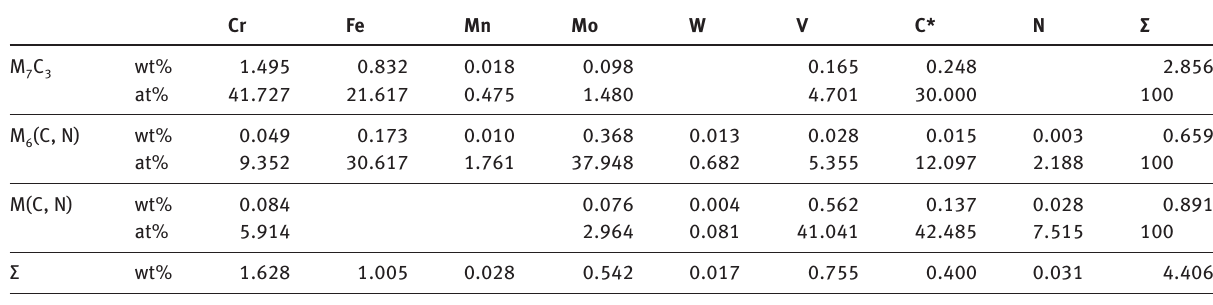
Table 3: Phase composition analyses of carbides Cr Fe Mn Mo